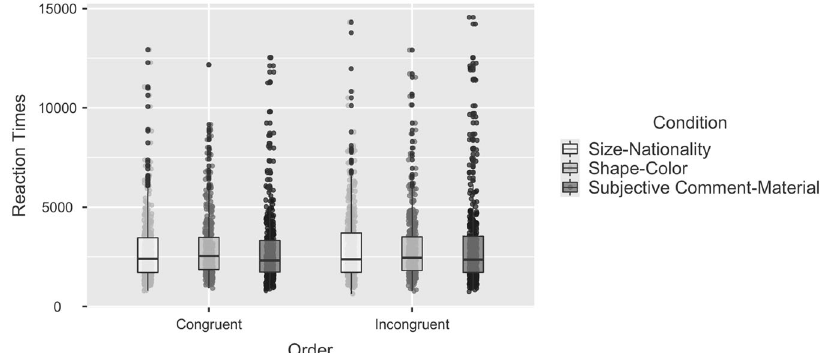
Fig. 4 RTs split by order and condition. The y -axis shows inverse-transformed ms.